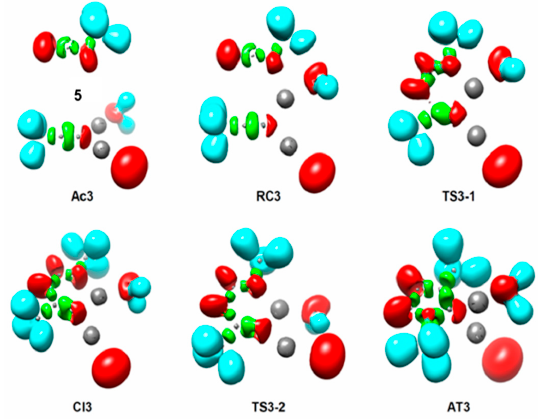
Figure 15. ELF localization domains (represented at an ELF value of 0.75) of the stationary points involved in the binuclear zw -type AgAAC reaction of Ac3 with 5 . ELF localization domains of TS3-1 were represented at ELF = 0.68 to show the V(C4) monosynaptic basin.